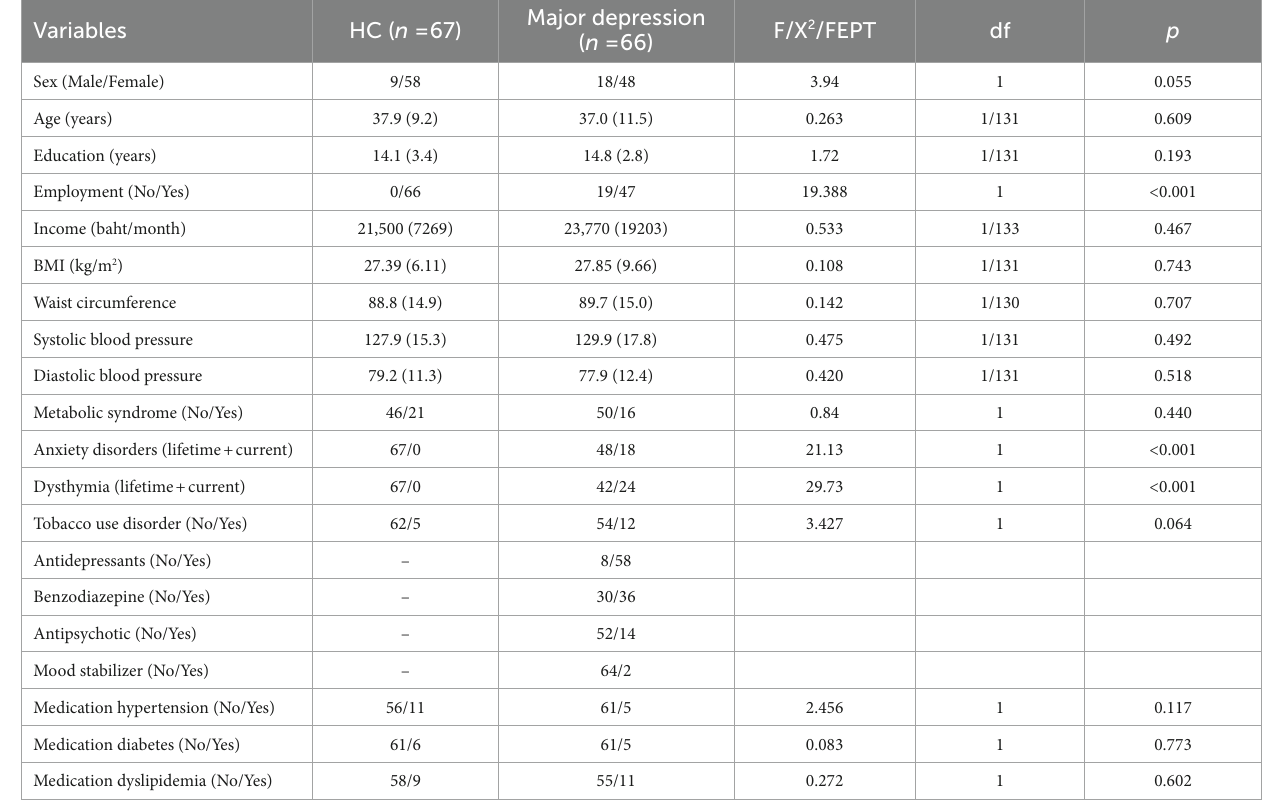
TABLE 1 Demographic and clinical data of the Major Depression patients and healthy controls (HC) included in the present study.